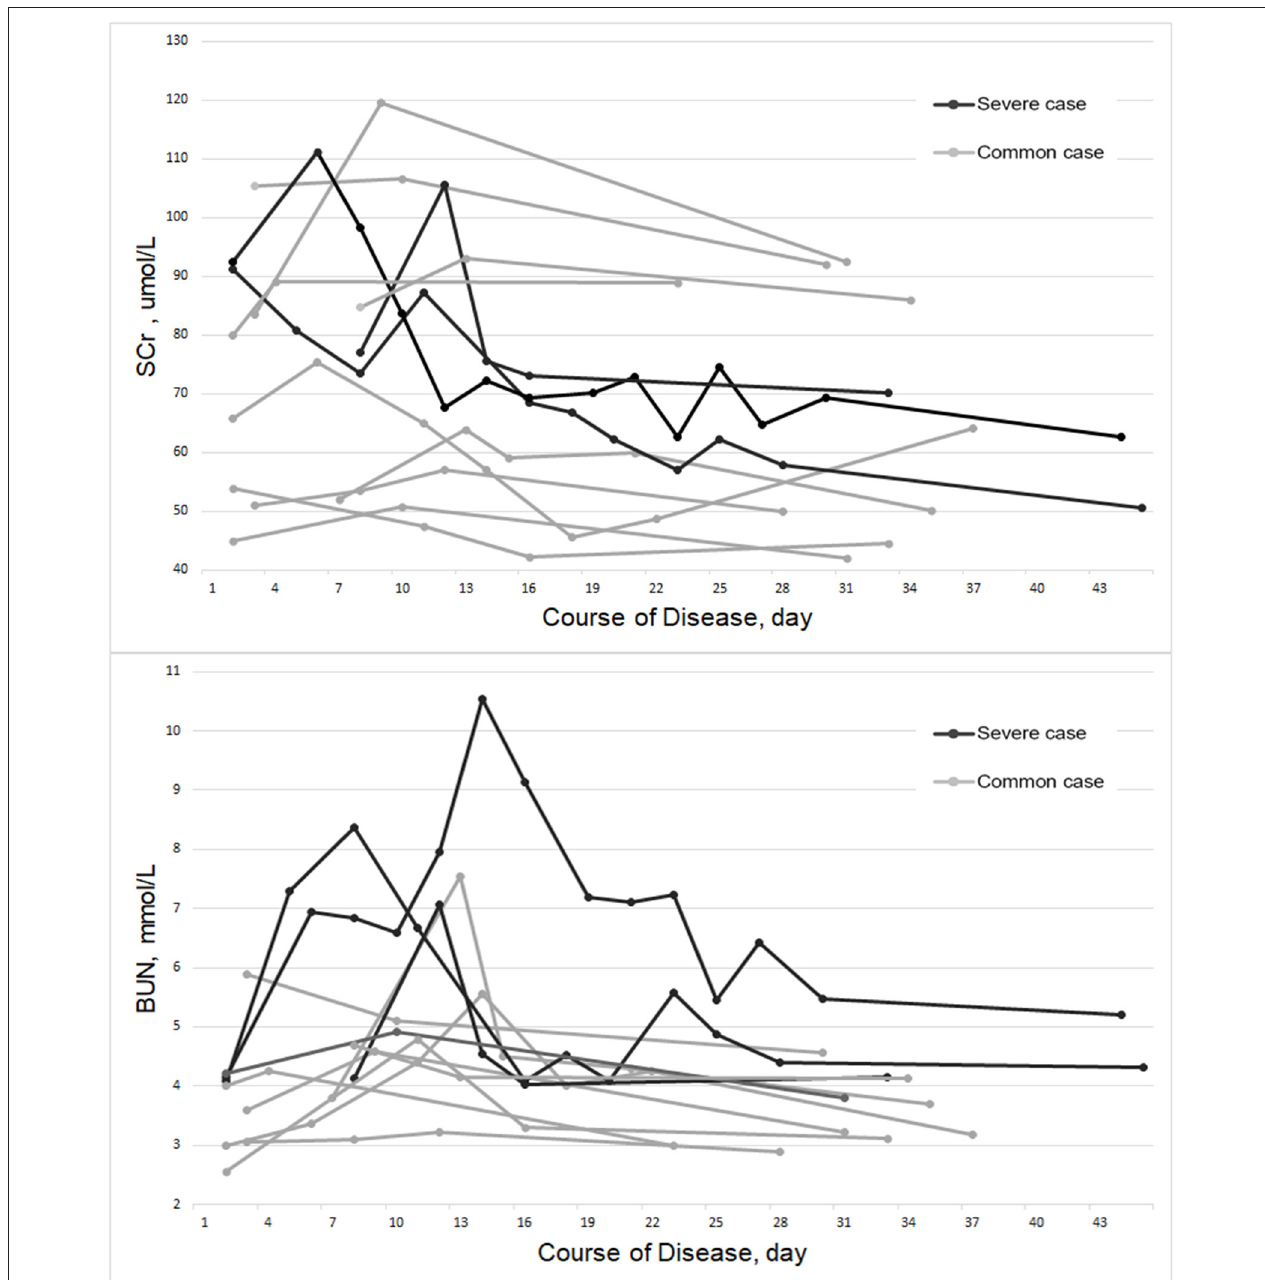
FIGURE 1 | Fluctuations in Scr and BUN of the COVID-19 patients from admission to recovery.